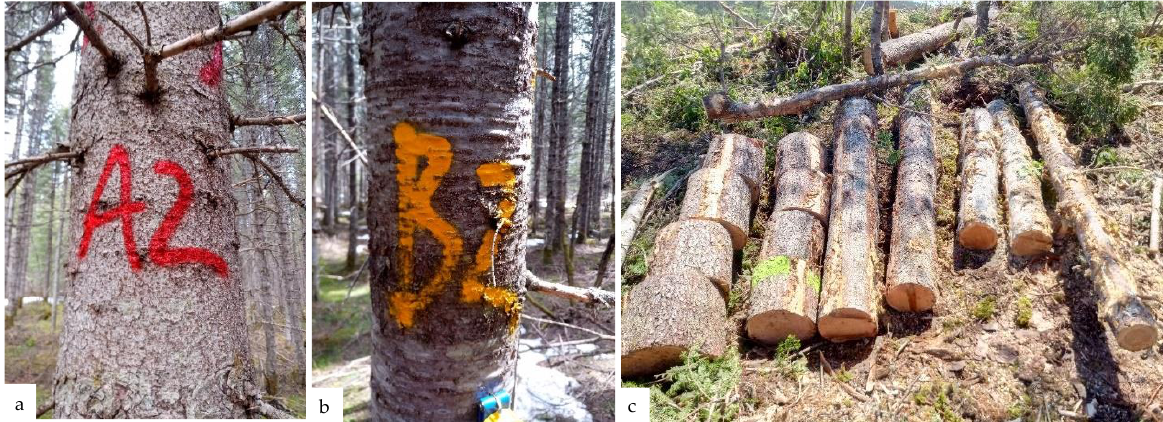
Figure 2. Example of alphanumeric code painted on study trees ( a ) White Spruce ( b ) Balsam fir; ( c ) Example of stem reconstruction.